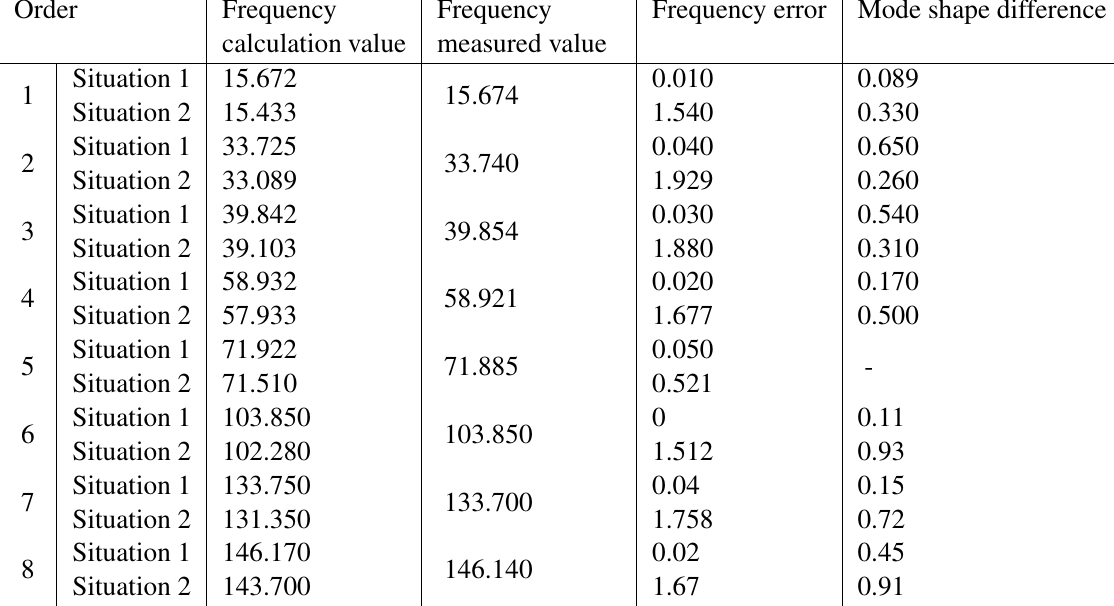
Table 2 Comparison of calculated and measured values of modal parameters after correction